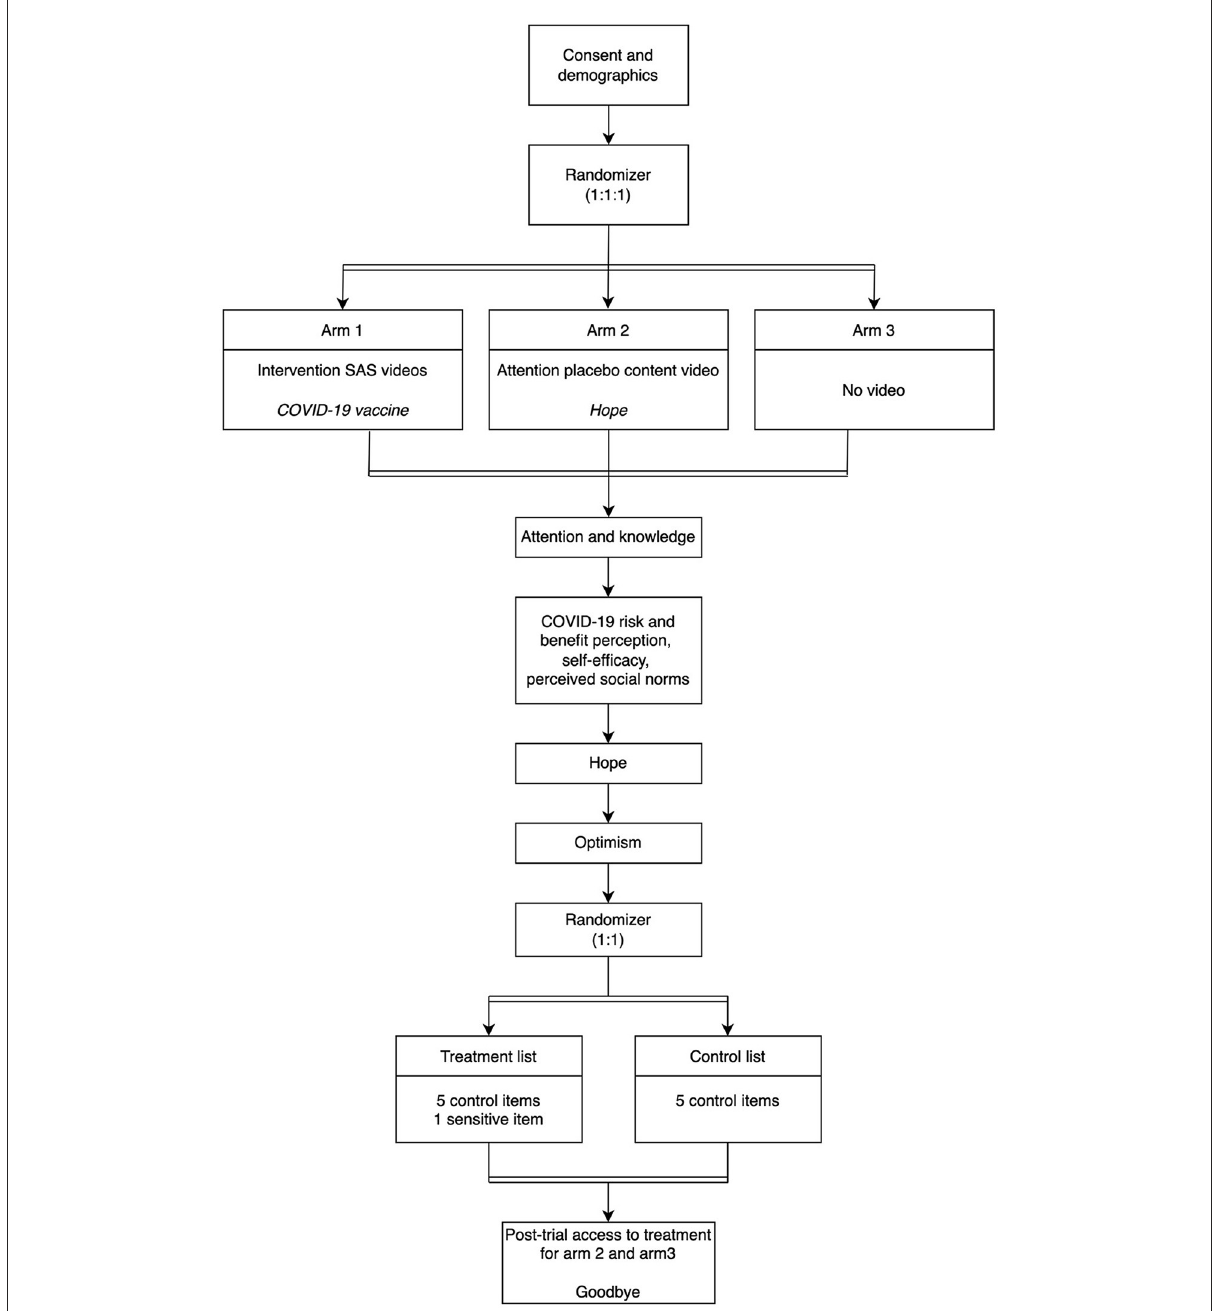
FIGURE1 Design of randomized controlled trials (second randomization is for a list experiment rather than for the group assignment). The order of the attention, knowledge, hope, and optimism questionnaires is sequential, since study participants complete them in succession. Inclusion criteria: Participants must be over the age of 18 (male, female, or other), have a current address in the United States, and be proficient in English.